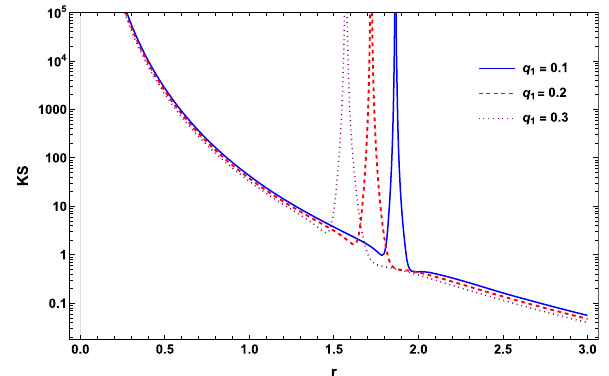
Fig. 5 Variation of the Kretschmann scalar (KS) of the EMPG black hole with the radial distance r for q 2 = 1 and different values of q 1 with σ = 0 and γ = 1. The KS is seen to develop two singularities, one at the origin r = 0 (independent of parameters) and the other at the horizon r = r H (dependent of the